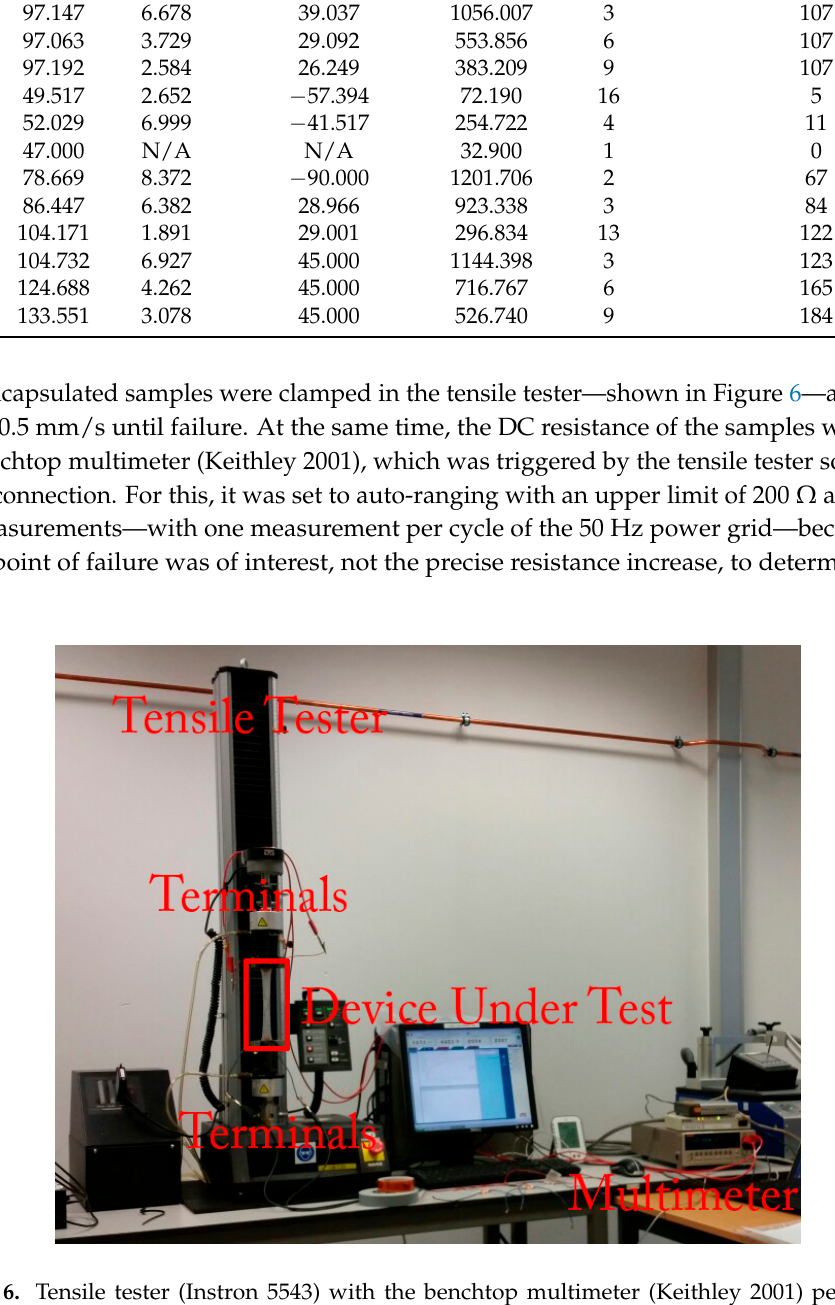
Figure 7. The resistance of the 66.6 m long meander plotted as a function of its extension. A noticeable, but procentual small drop in resistance was observed as the meander was extended, most likely due